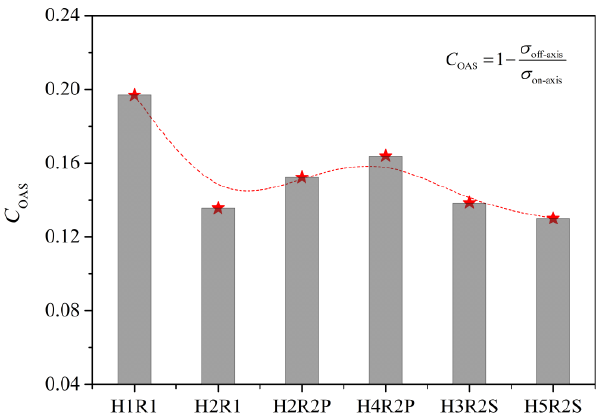
Figure 11. Effect of hole arrangement on off-axis dependence of notched strength of Glare.